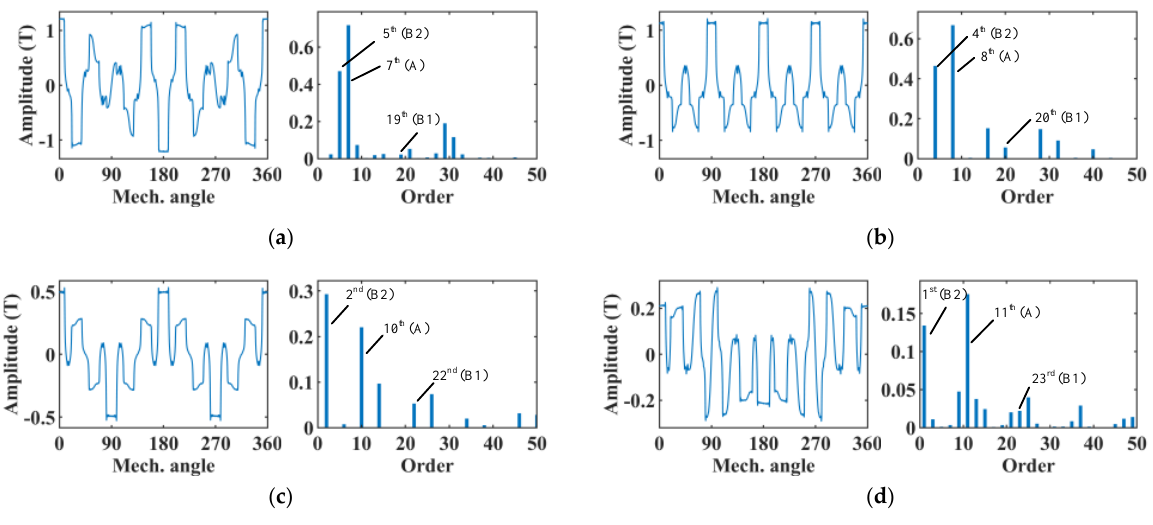
Figure 11. The flux density distribution and their FFT analysis in the airgap of four cases. ( a ) 12/7; ( b ) 12/8; ( c ) 12/10; ( d ) 12/11.